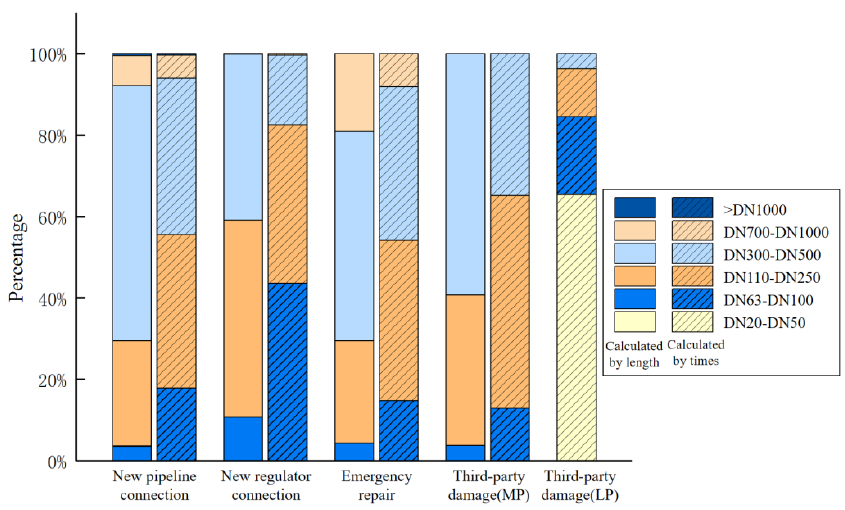
Figure 8. Distribution of diameter of emission sources.